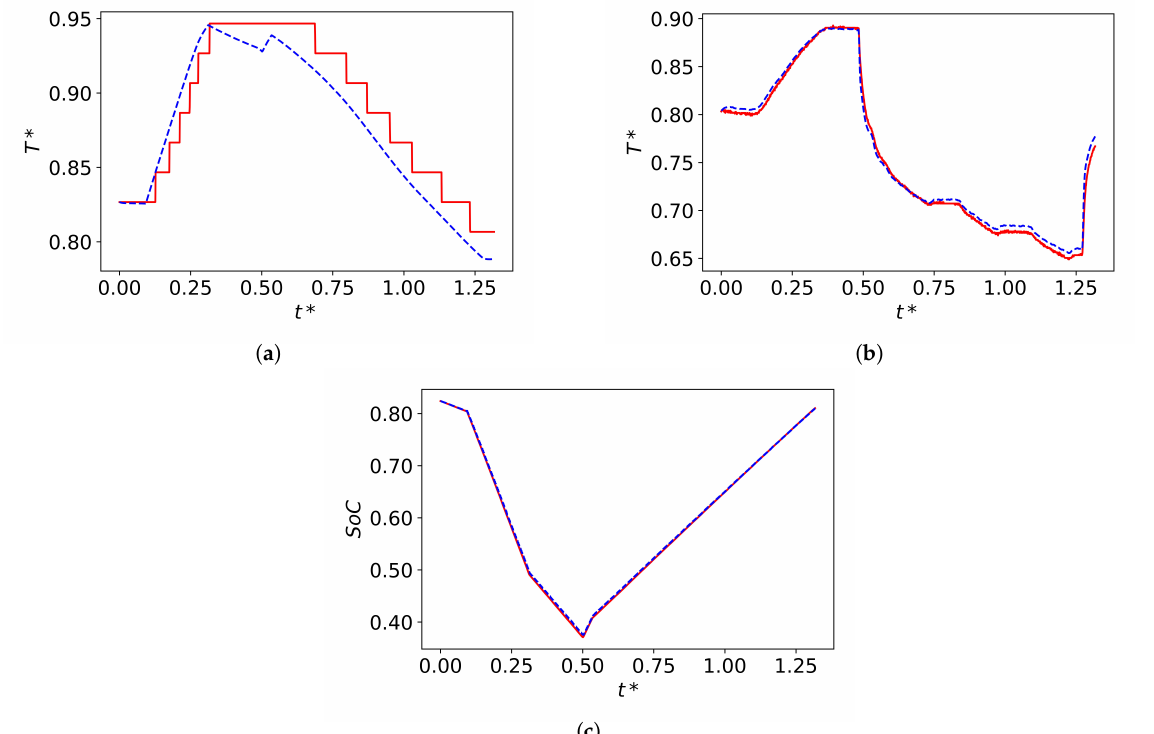
Figure 8. Results for Case 2: ( a ) average battery pack temperature, ( b ) outlet coolant temperature and ( c ) average battery pack SoC. Measured quantity ; simulated quantity